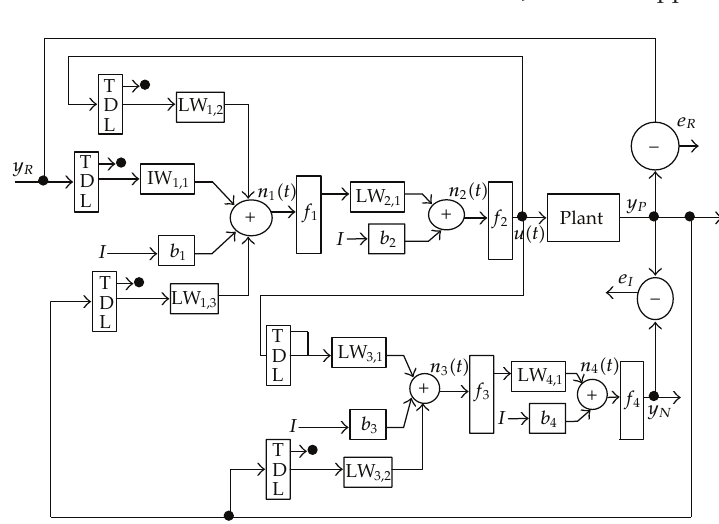
Figure 4: Network structure of model reference control (cid:4) 41 (cid:5)